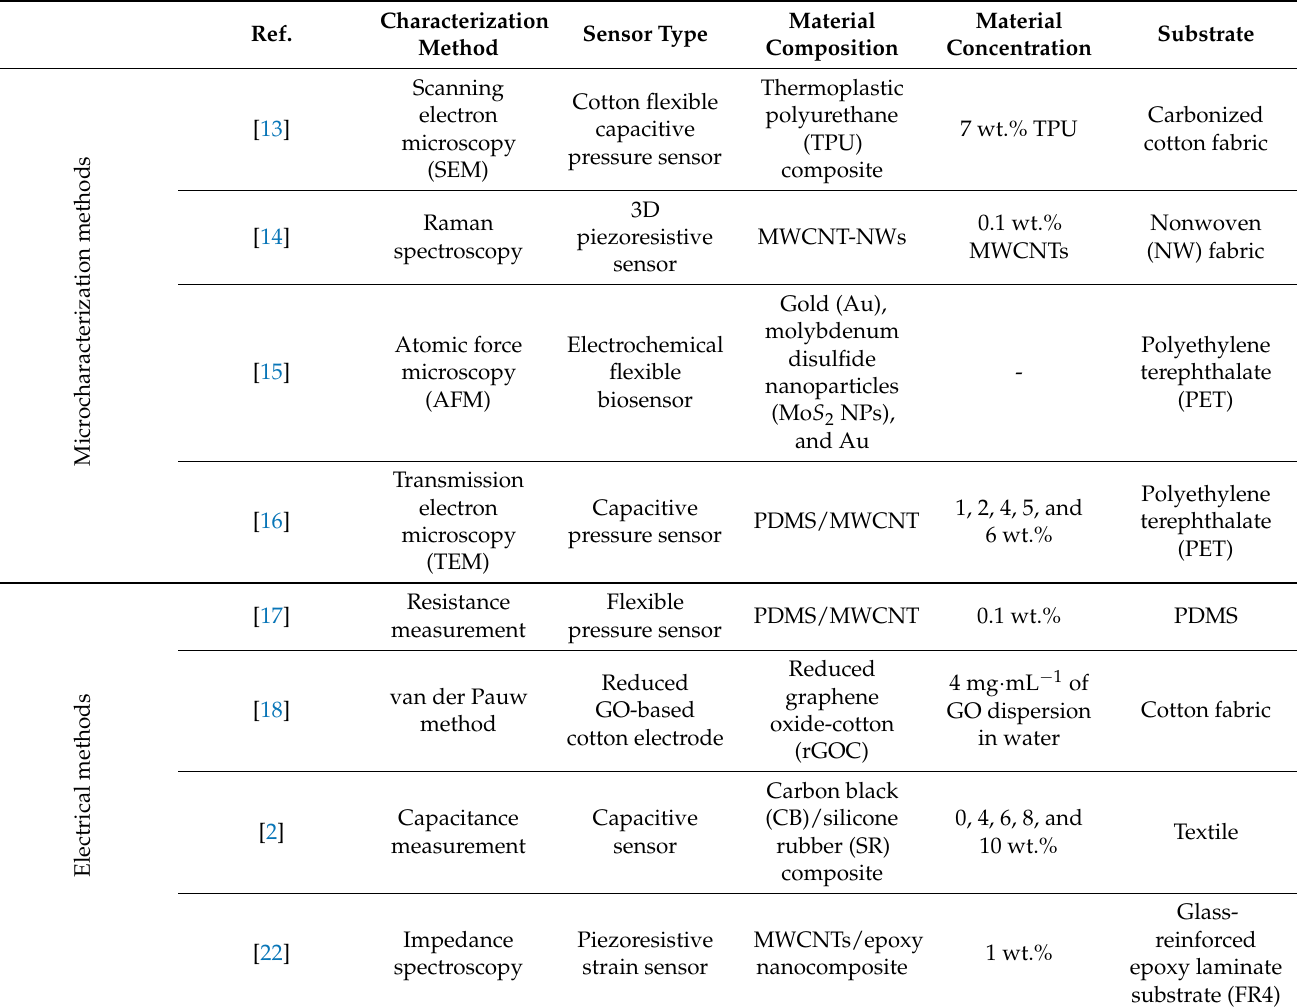
Table 1. Characterization methods for nanocomposite sensors.